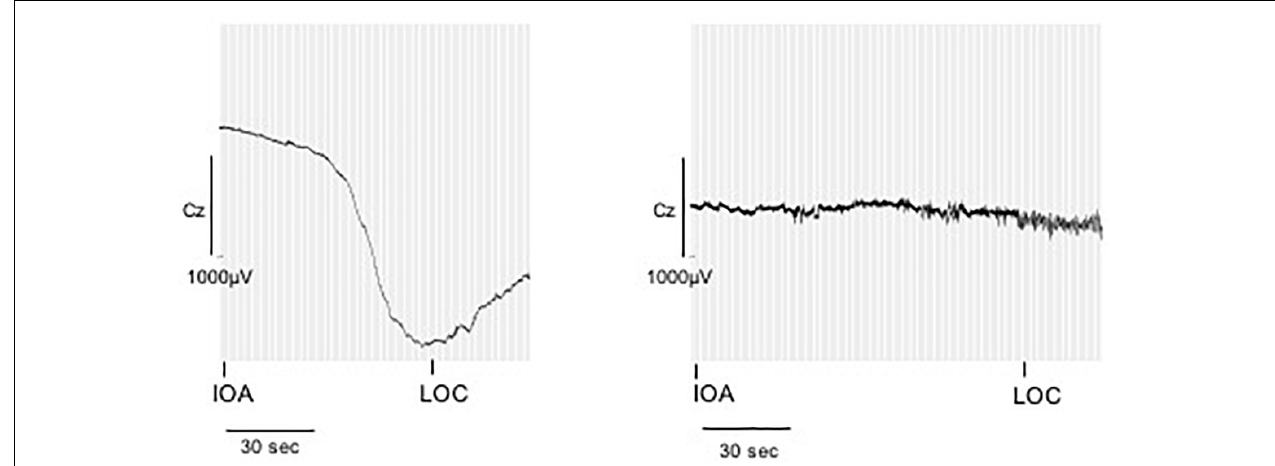
FIGURE 5 | Direct current shifts during anesthesia induction. DC shifts of two example patients during anesthetic induction. The marker IOA represents the onset of narcotic administration, LOC represents loss of consciousness, here defined as loss of the eyelid closure reflex. While some patients presented with marked DC shifts in response to IOA, especially around LOC, others showed only small drifts of the DC potential.